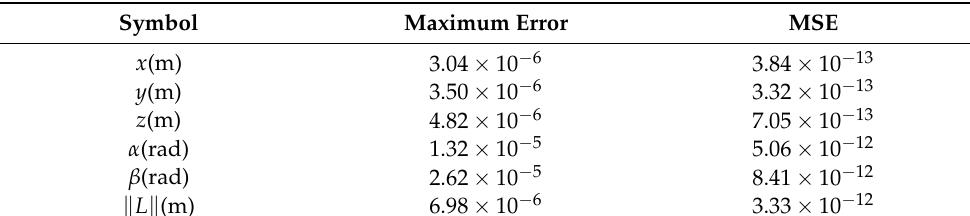
Table 3. The performances of the DNN after training on the dimensional test data set.